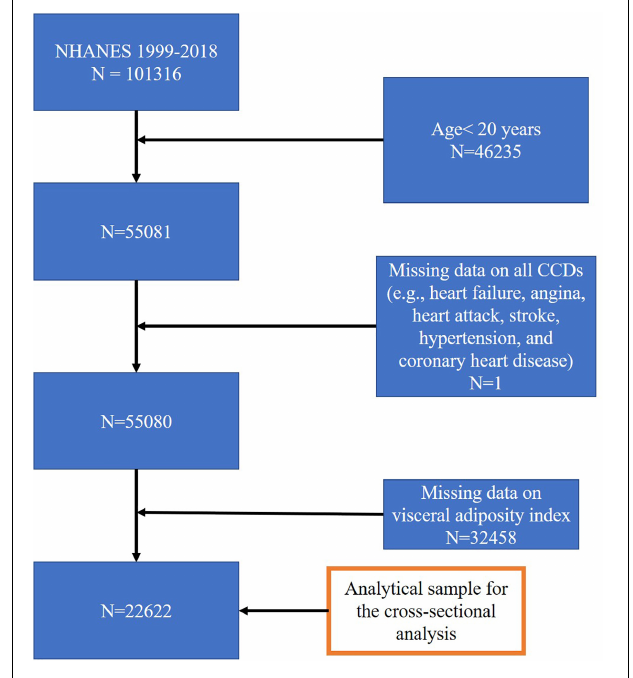
FIGURE 1 | Sample selection process flow